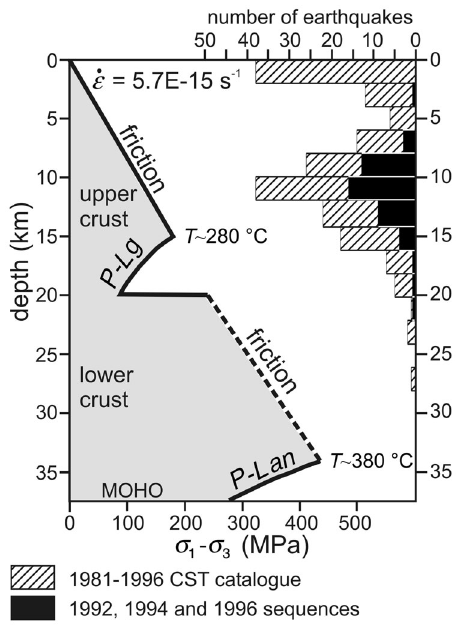
Fig. 6. Rheological profile (in stress difference) for the crust in the Amatrice-Campotosto area and depth distribution of the seismicity (seismicity selection in fig. 4). Frictional failure law for brittle behaviour (friction) and power-law creep rheology for plastic behaviour ( P - Lg = granite power-law creep; P - Lan = = anorthosite power-law creep) are compared; ε • = lon- gitudinal strain rate from geodetic measurements (D’Agostino et al. , 2001). Creep parameters for gran- ite: A (empirical material constant) = 1.8 E -9 MPa − n ⋅ s − 1 , n (stress exponent) = 3.2, E (activation energy) = = 123 kJ ⋅ mol − 1 ; creep parameters for anorthosite: A = = 3.2 E -4 MPa − n ⋅ s − 1 , n = 3.2, E = 238 kJ ⋅ mol − 1 (from Ranalli,